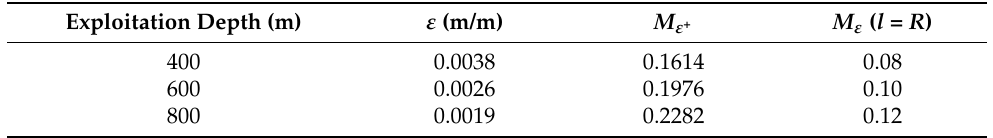
Table 3. Detailed calculations for the obtained theoretical solution carried out for the depth range from 400 to 800 m (own